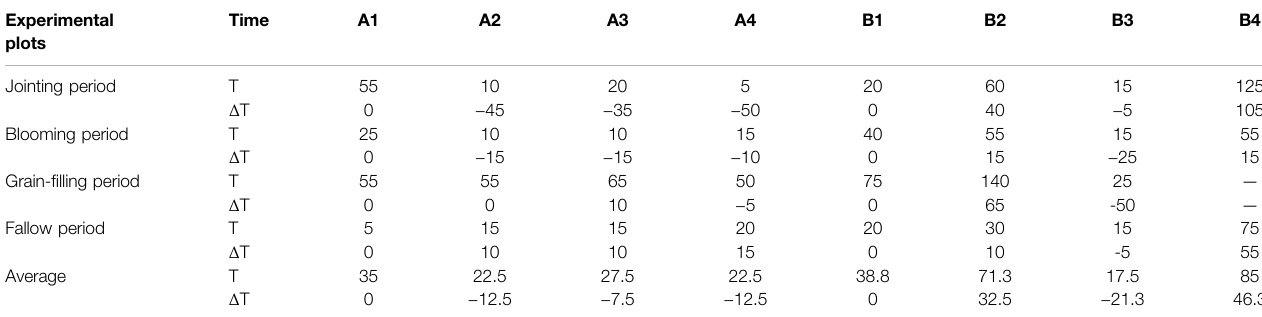
TABLE 3 | Start time of runoff in different experimental stages and plots. Experimental plots